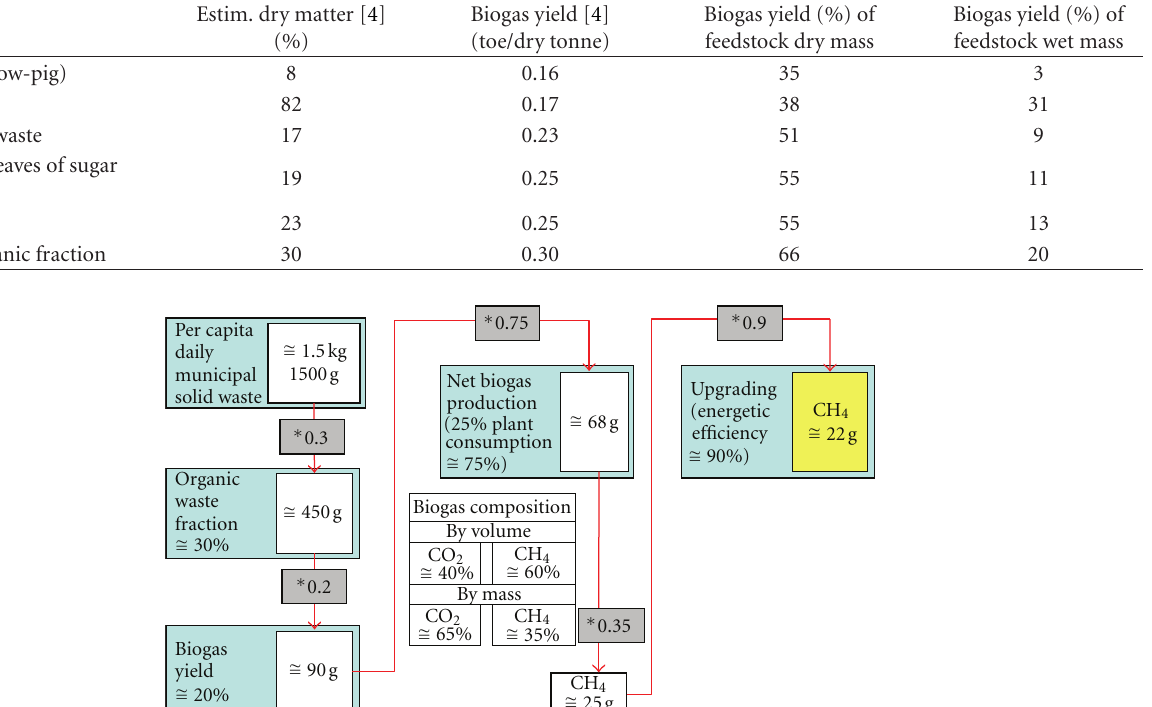
better than the MT due to a higher electrical (and often also overall) e ffi ciency